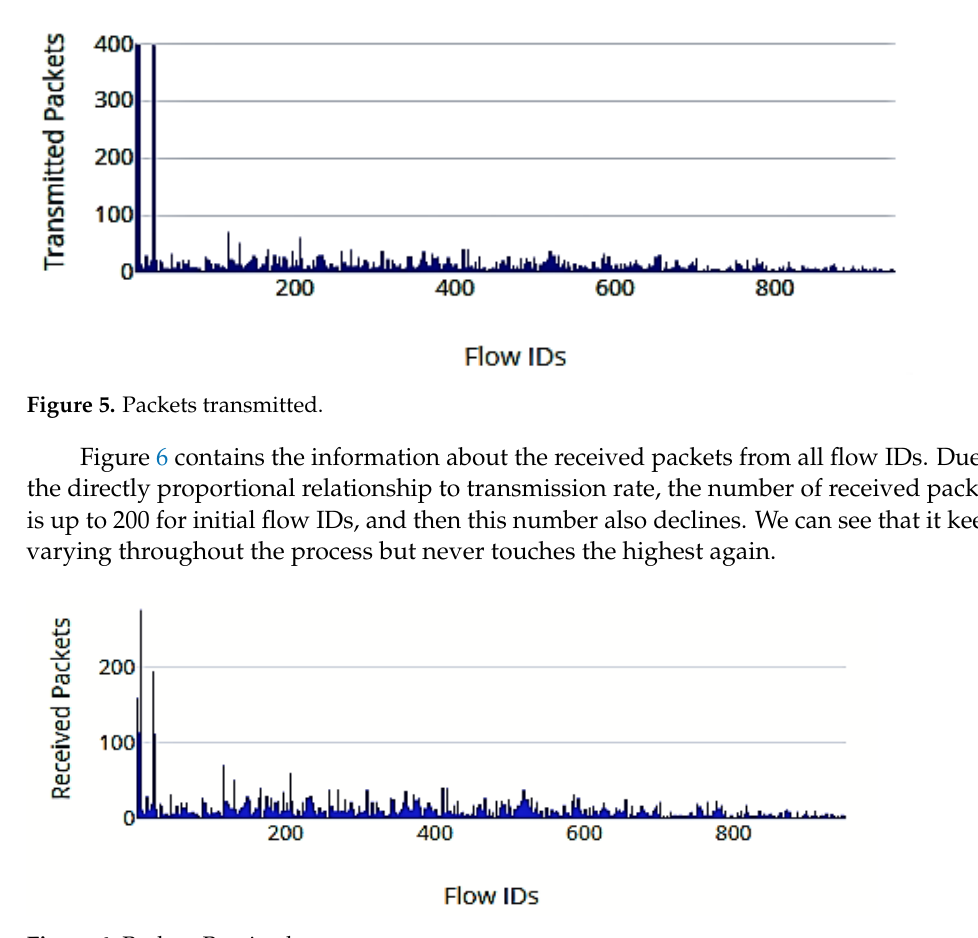
Figure 6. Packets Received.